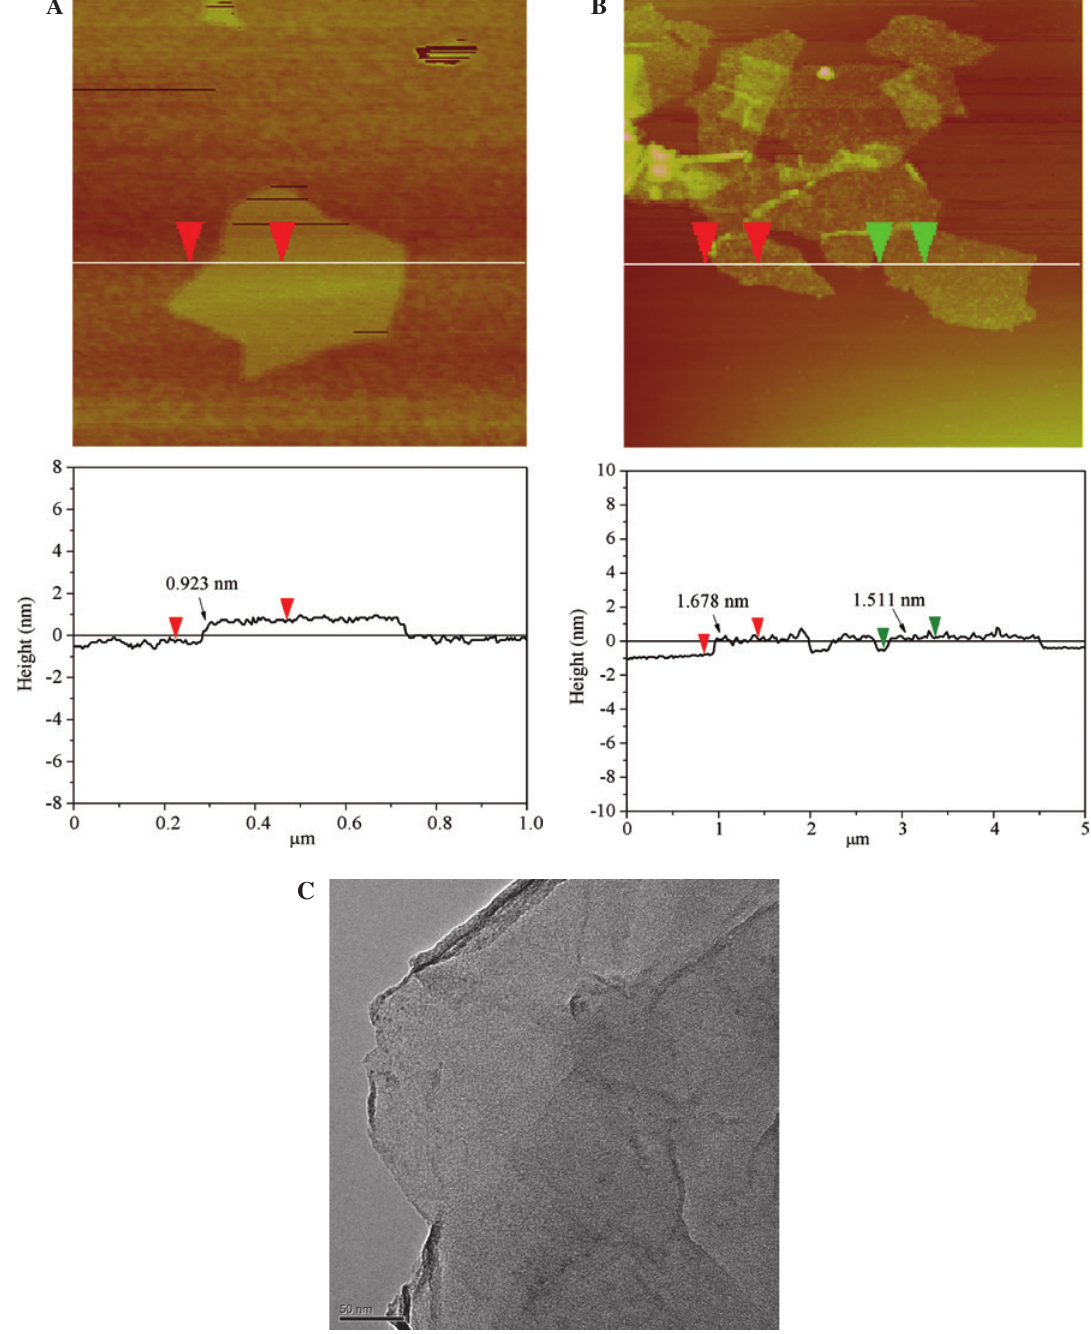
Figure 3: AFM images and the corresponding height profiles of (A) GO and (B) GO@PDOPA nanosheets. (C) TEM image of GO@PDOPA